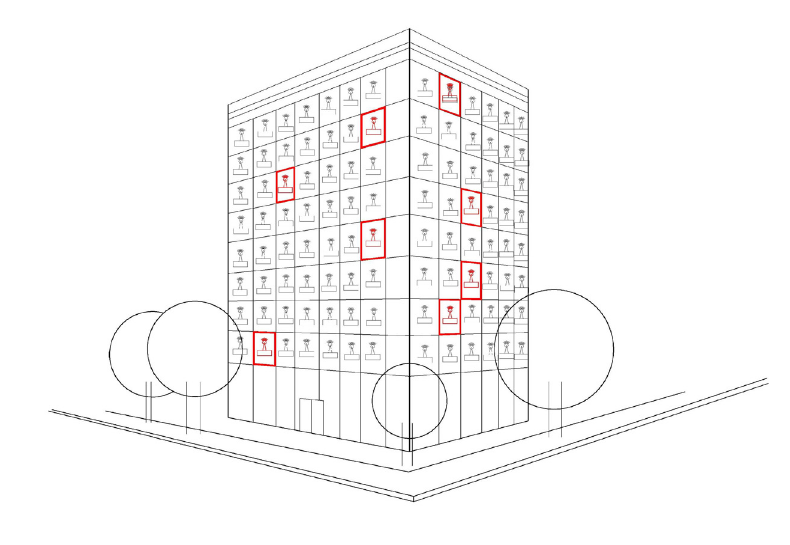
Figure 2. The deployment of the nodes on floors and in rooms on each of the